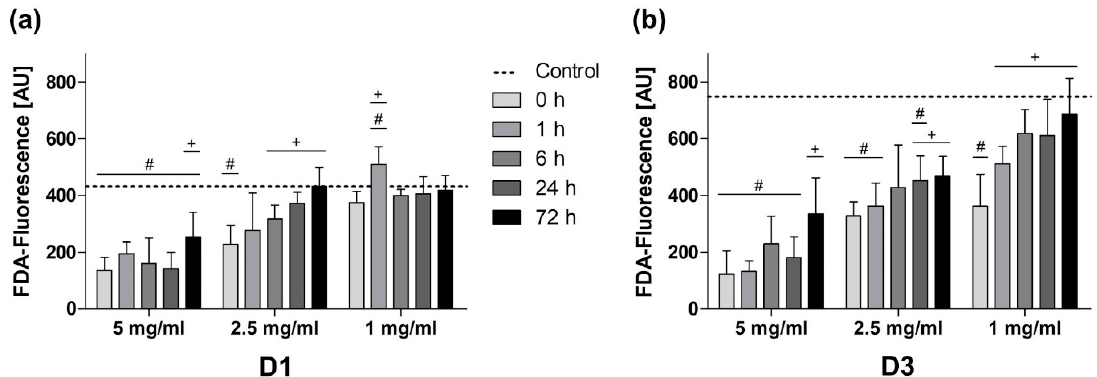
Figure 5. Quantification of cell viability at di ff erent BG concentrations on ( a ) D1 and ( b ) D3. Values are shown as means with standard deviation. Significant di ff erences to the BG-free control group (shown as a dotted line) are indicated by (#) and significant di ff erences to the non-passivated BG group are designated by (+).